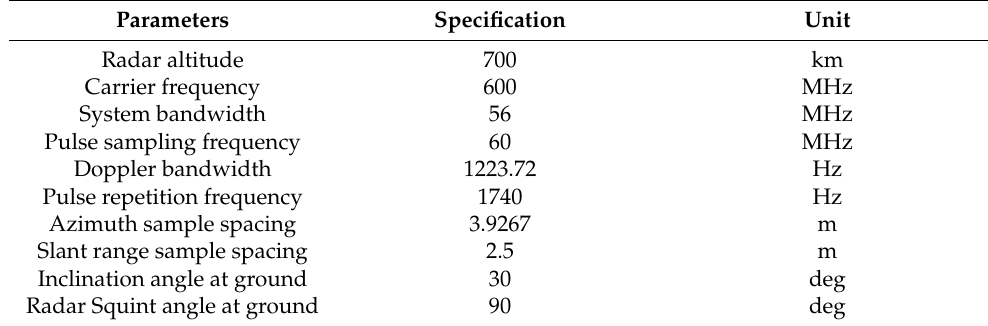
Table 1. System parameters of a spaceborne P-band full-Pol SAR system.